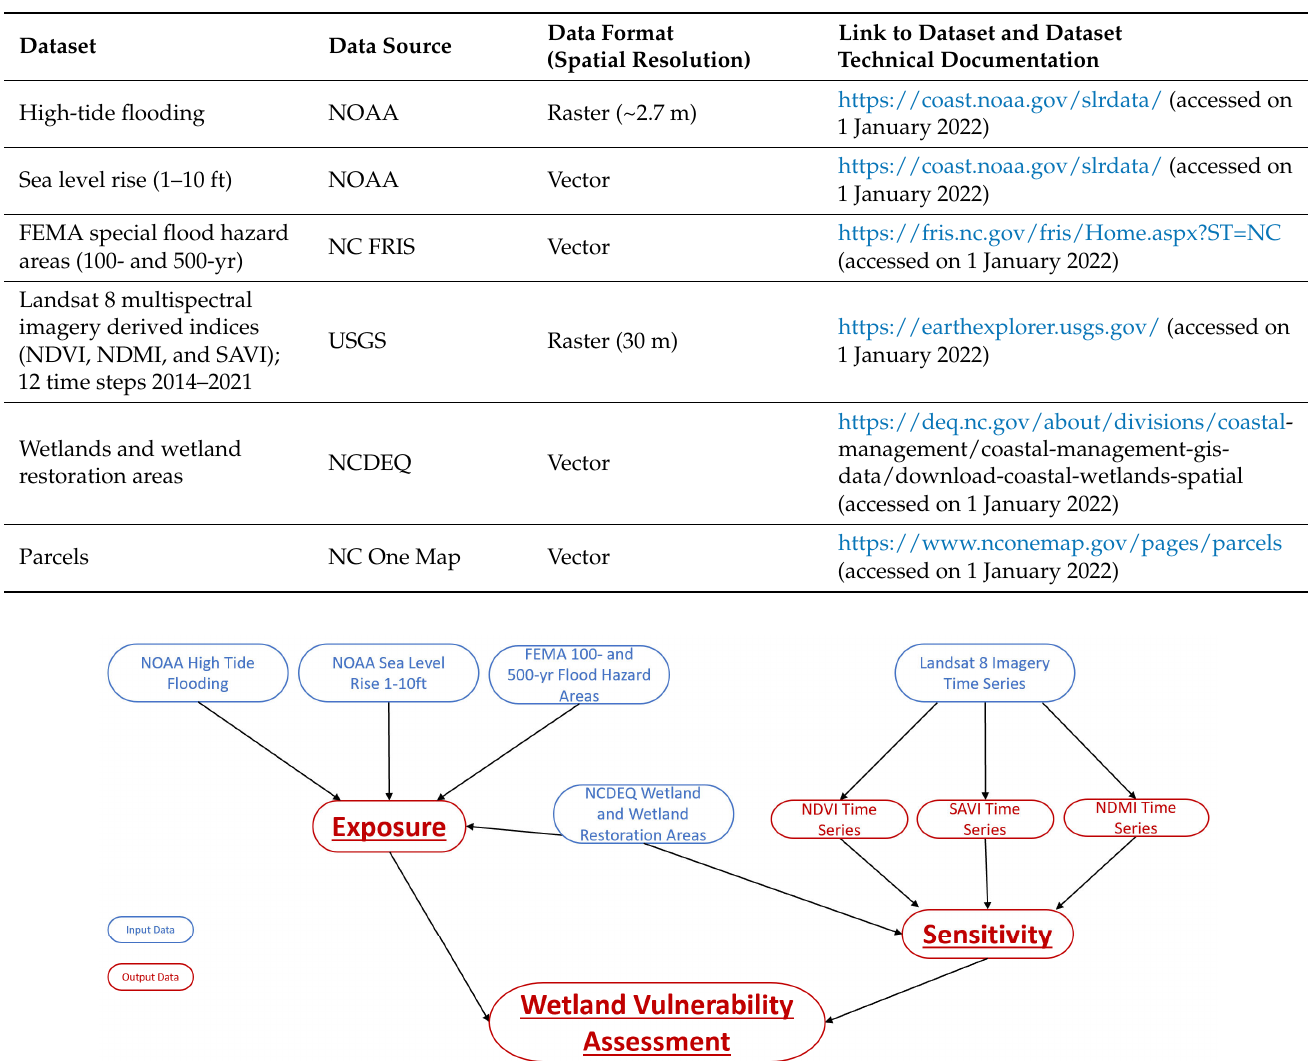
Table 1. Wetland vulnerability assessment datasets and sources.